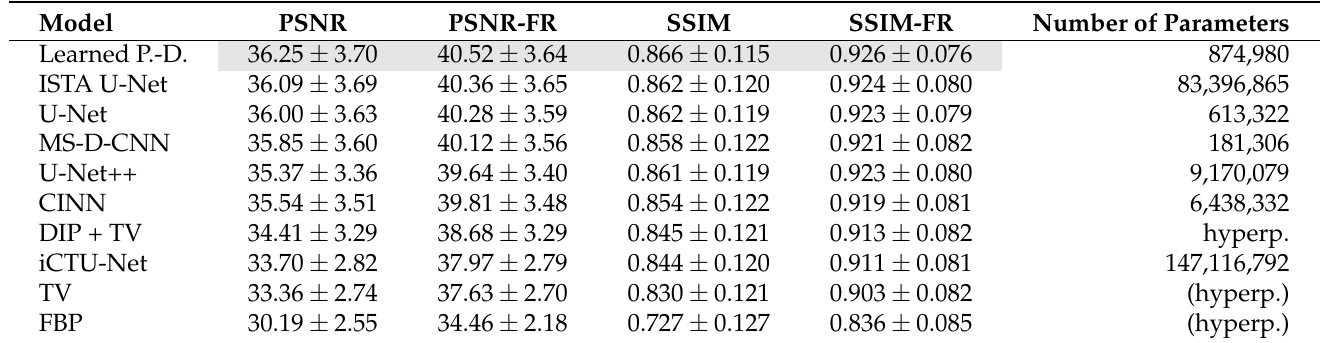
Table 2. Results on the LoDoPaB-CT challenge set. Methods are ranked by their overall performance. The highest value for each metric is highlighted. All values are taken from the official challenge leaderboard https://lodopab.grand-challenge. org/evaluation/challenge/leaderboard/ (accessed on 4 January